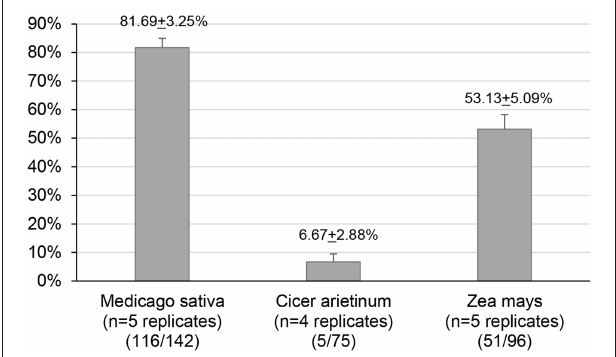
FIGURE 3 | Host plant preference. Helicoverpa armigera larvae total parasitism rates (% ± SE) by Hyposoter didymator depending on the host plant on which H. armigera larvae were feeding. The number of parasitized caterpillars relative to the number of caterpillars recovered in the experiment (all replicates merged) is indicated in parentheses at the bottom of the graph